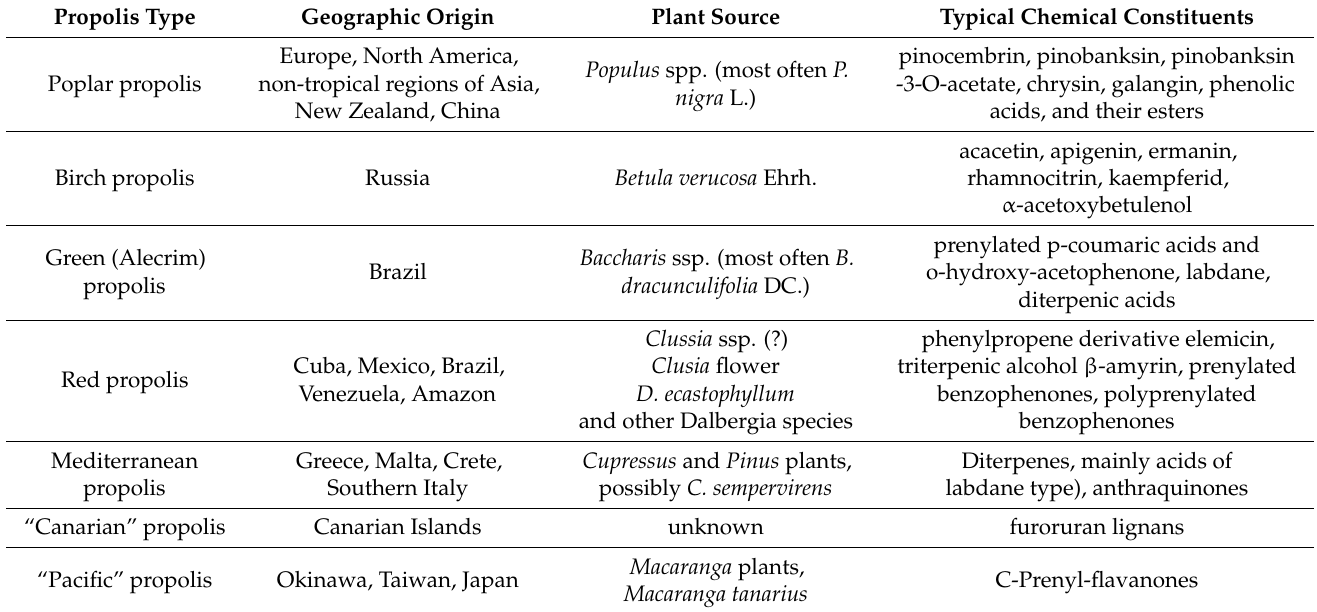
Table 8. The most important propolis types: geographical origin and major